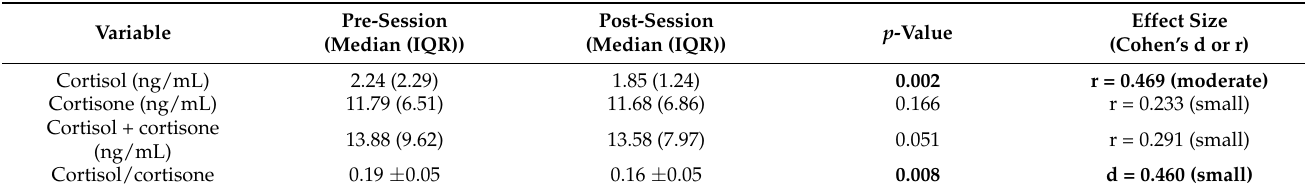
Table 3. Biochemical stress markers before and after relaxation session.